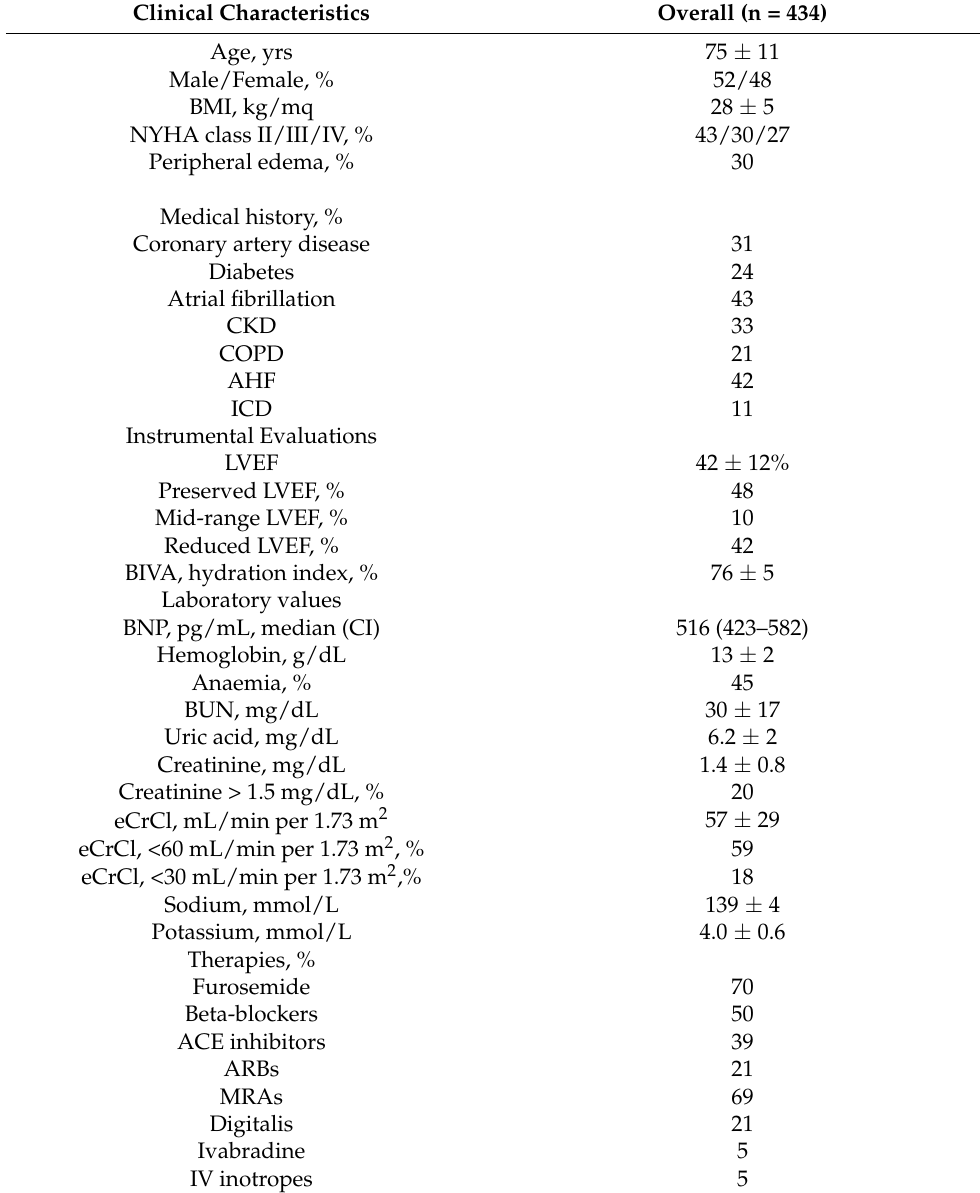
Table 1. Patient characteristics of all